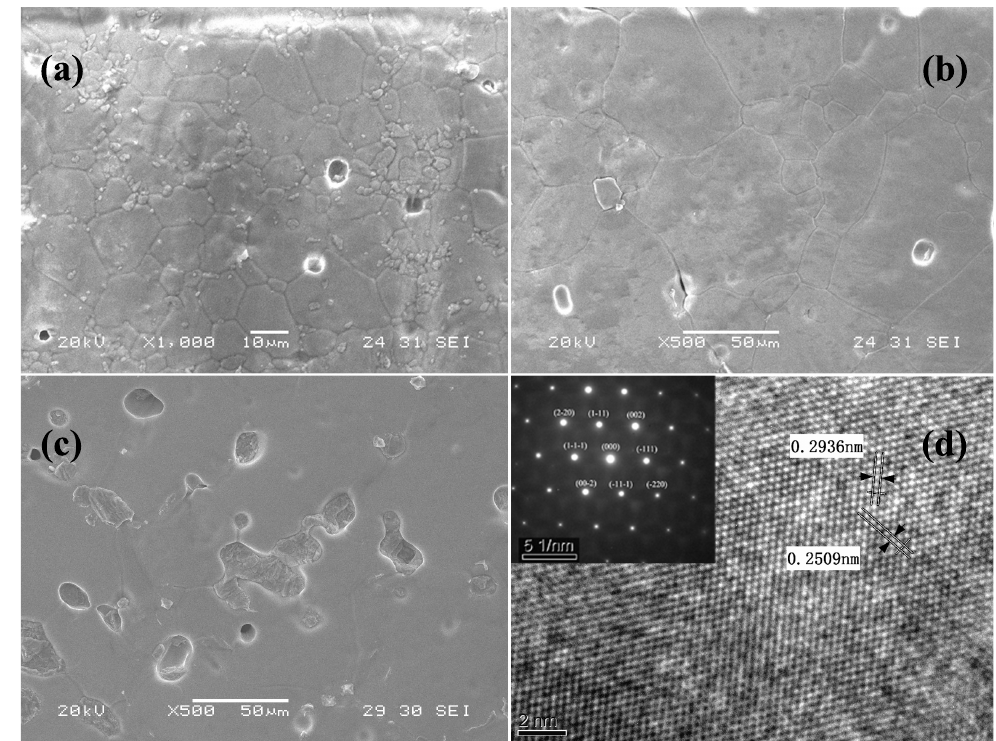
Figure 2. ( a – d ) SEM micrographs of Zr 1 − x Mn x O 2 − δ solid solution ( a ) x = 0.15, ( b ) x = 0.20, ( c ) x = 0.25, HRTEM images and the SAED pattern from a single grain of Zr 0.80 Mn 0.20 O 2 − δ along the [110] zone